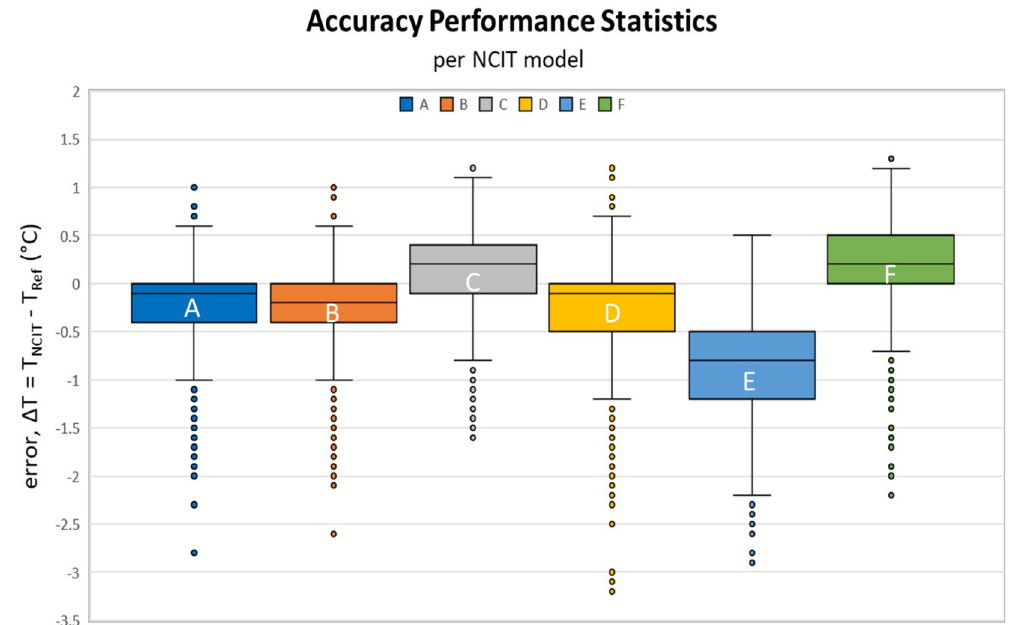
Figure 1. Accuracy performance statistics for each NCIT model for Trial #1. The midline indicates the median, the box top captures 25% of the data above the median and the box bottom captures 25% of the data below the median. The whiskers (error bars) represent that maximum and the minimum ΔT. The circles represent outlier data.